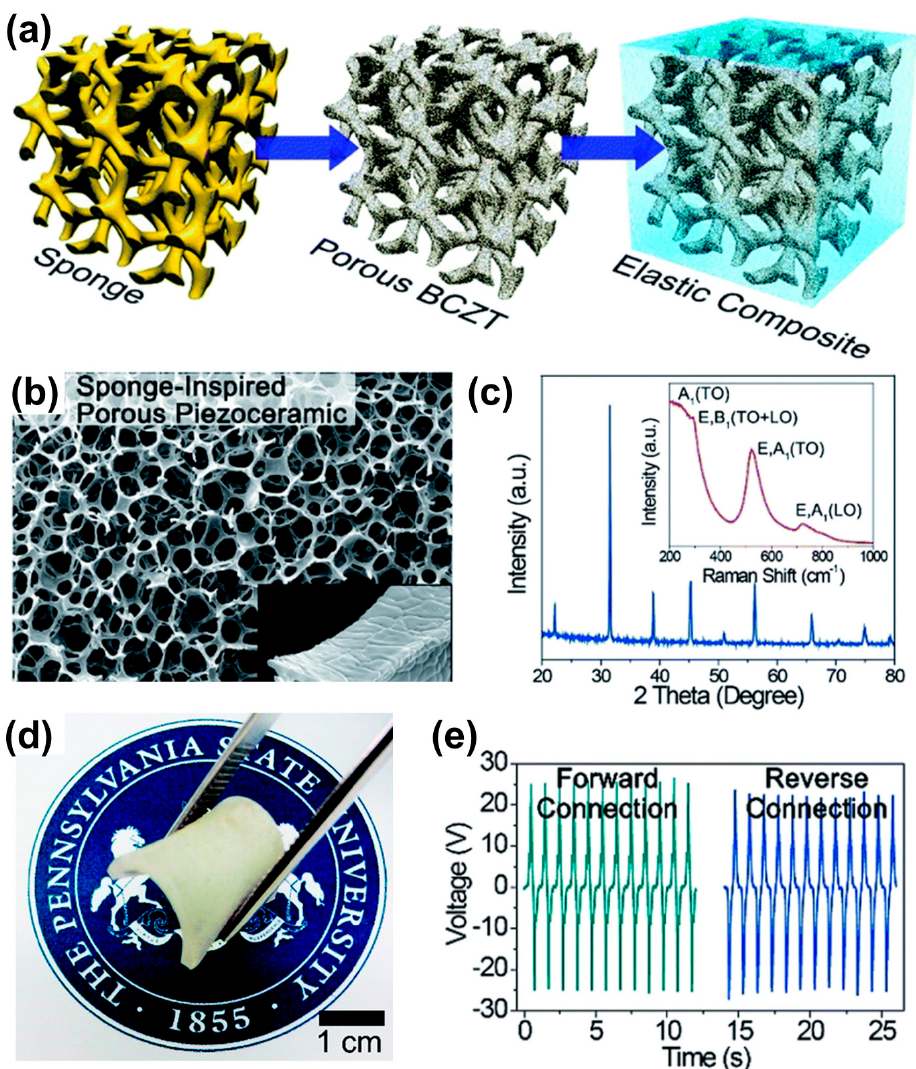
Figure 5. ( a ) Schematic diagram of the synthesis process of the sea sponge − inspired 3D piezoelectric composite. ( b ) SEM micrograph of the BCZT porous structure. A cross − sectional SEM micrograph of the porous BCZT. ( c ) XRD pattern and Raman spectrum (inset) of the sea sponge − inspired BCZT porous structure. ( d ) A photograph of elastic PCG. ( e ) Generated open − circuit voltage signals from PCG by compressing and releasing under forward and reverse connections. Reproduced with permission [81].